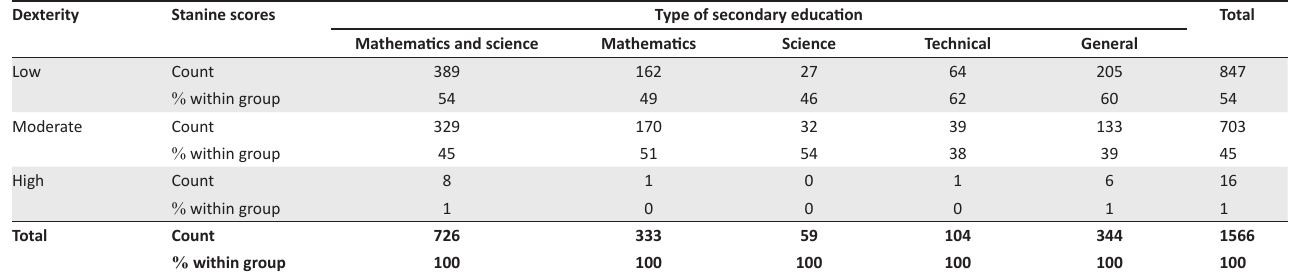
TABLE 2: Contingency table of observed frequencies for the dexterity sub-test. Dexterity